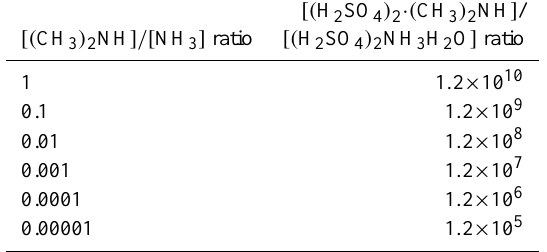
Table 3. Ratio of concentrations of clusters of two sulfuric acids with one dimethylamine to two sulfuric acids with one ammonia and one water, as a function of the dimethylamine to ammonia con- centration ratio. Equilibrium steady-state conditions are assumed and T = 298 . 15K, P = 1atm and RH =